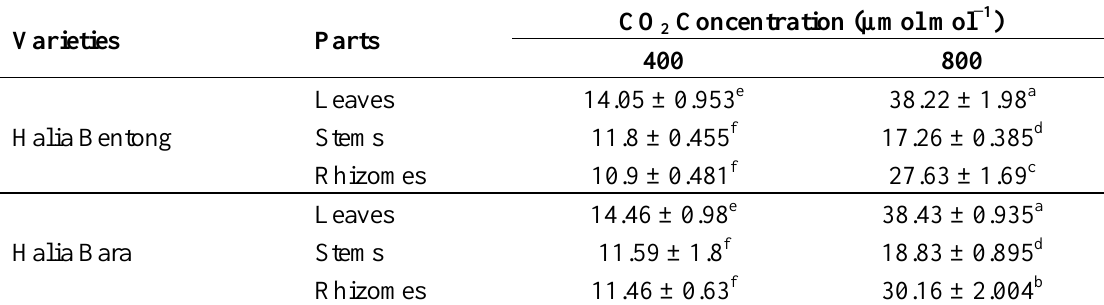
Table 3. Total soluble carbohydrate content in different parts of ginger ( Z. officinale ) varieties grown under different CO 2